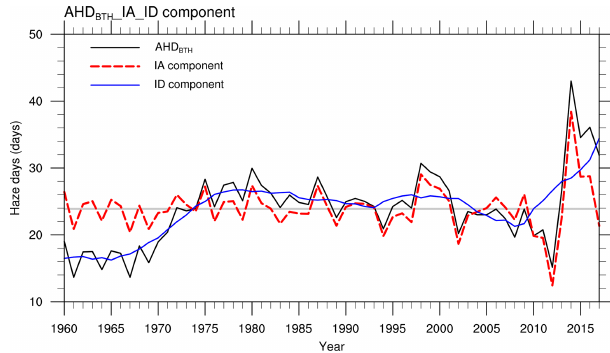
Figure 2. Time series of the raw AHD BTH (black line; days), along with its interdecadal component (blue line; days) and inter- annual component (red line; days), for the period 1960–2017. The gray horizontal line delineates the average climate value of the raw AHD BTH during